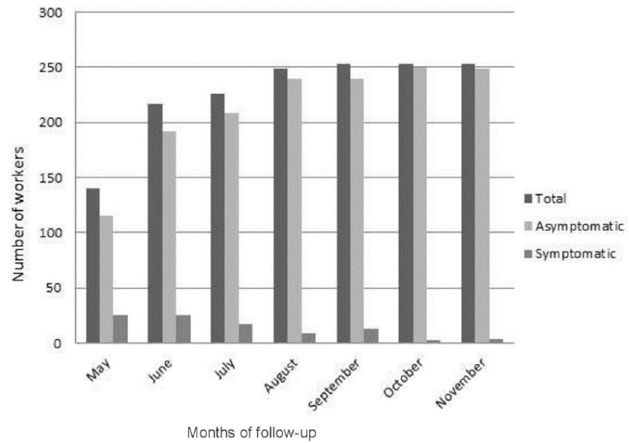
Figure 2. Number of workers who completed the questionnaire (total), number of these workers who reported signs and/or symptoms related to COVID-19 (symptomatic), and number of work-